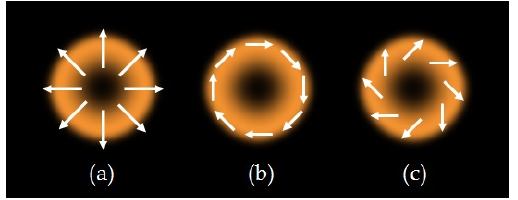
Figure 5. Spatial distributions of instantaneous electric vector field for ( a ) radially polarized mode; ( b ) azimuthally polarized mode; and ( c ) generalized cylindrical vector (CV) beams as a linear superposition of ( a ) and ( b ).